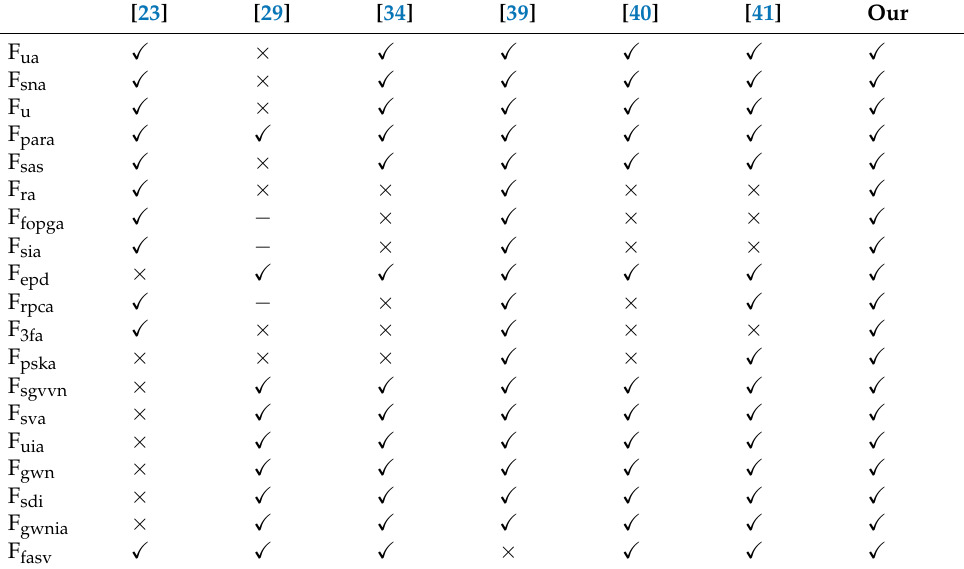
Table 6. Comparison of functionality features.